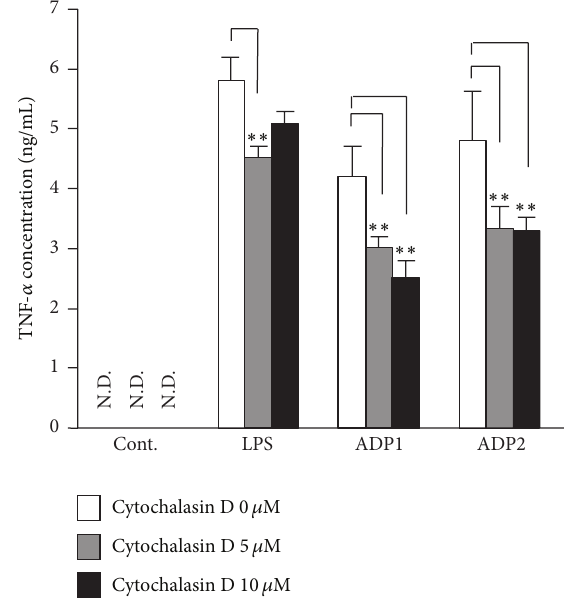
Figure 3: Cytochalasin D inhibited Asian dust particles-induced tumor necrosis factor- 𝛼 (TNF- 𝛼 ) production in RAW264.7 cells. RAW264.7 cells were pretreated for 30 min with Cytochalasin D, an inhibitor of phagocytosis, and then treated for 6 h with 100 𝜇 g/mL of Asian dust particles (ADP1 or ADP2) or 1.5 𝜇 g/mL of LPS. Dimethyl sulfoxide (0.1%) vehicle was used as control (Cont.). The level of TNF- 𝛼 in culture supernatants was assessed by means of an enzyme- linked immunosorbent assay. Results are expressed as mean ± SD; 𝑛 = 6 ; ∗∗ 𝑃 < 0.01 ; N.D., not detected.